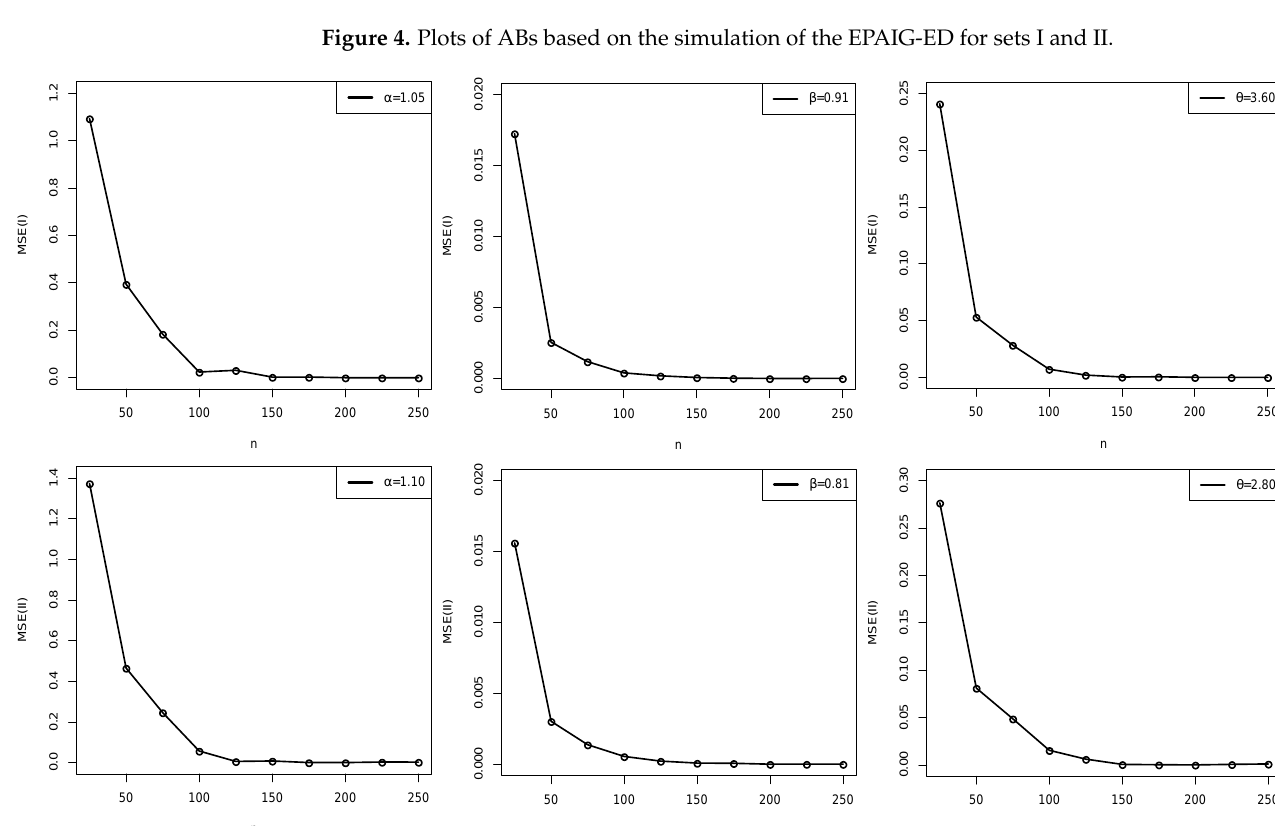
Figure 5. Plots of MSEs based on the simulation of the EPAIG-ED for sets I and